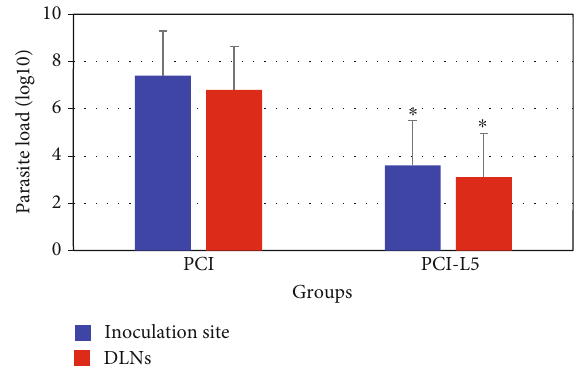
Figure 6: Log 10 of parasite burden in the site of inoculation and lymph nodes six week after the challenge. Parasite load was determined by limiting dilution after S.C. inoculation of 10 6 Leishmania tropica promastigotes into the right footpad. As geometric mean ± SD . ∗ P < 0 : 05 , signi fi cant decrease in the site of inoculation and lymph nodes parasite burden in the vaccinated group compared to the control